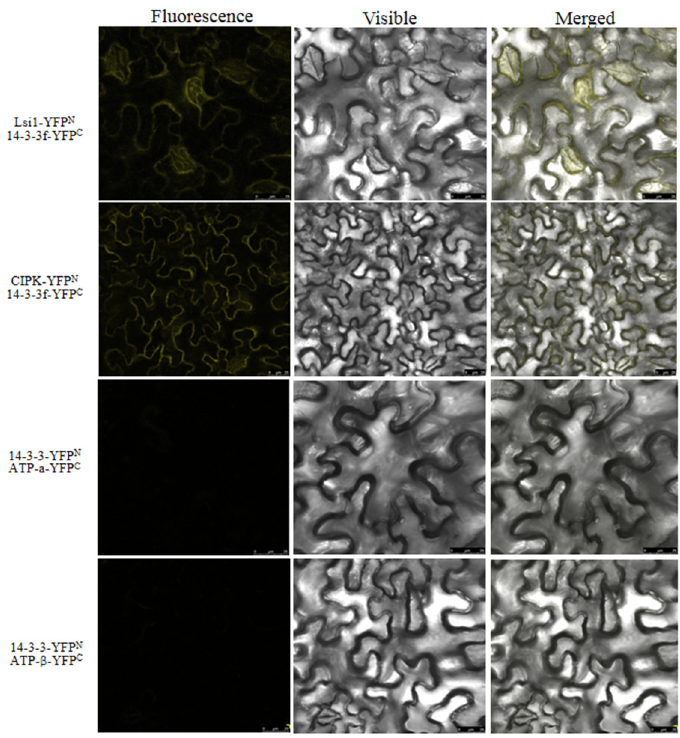
Figure 9. The BiFC confirmed the interaction proteins between 14-3-3f and NIP, 14-3-3f and CIPK.